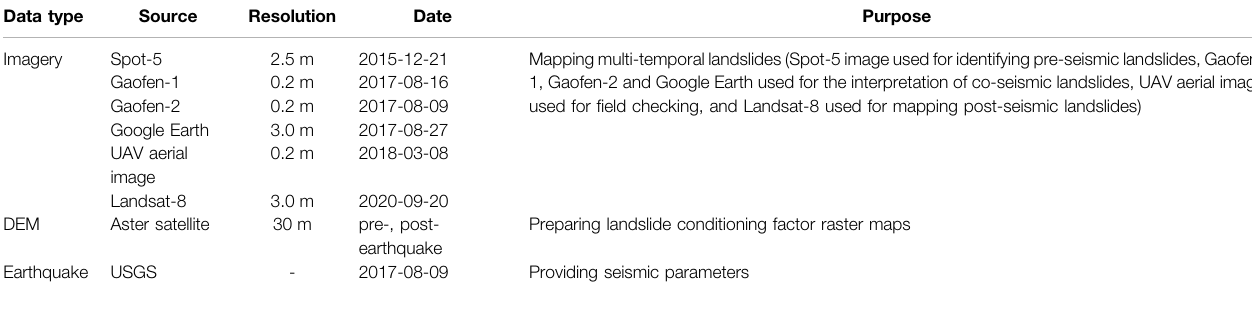
TABLE 2 | The type, source, and date of the data used for landslide mapping and the subsequent modeling procedure. USGS represents the U.S. Geologic